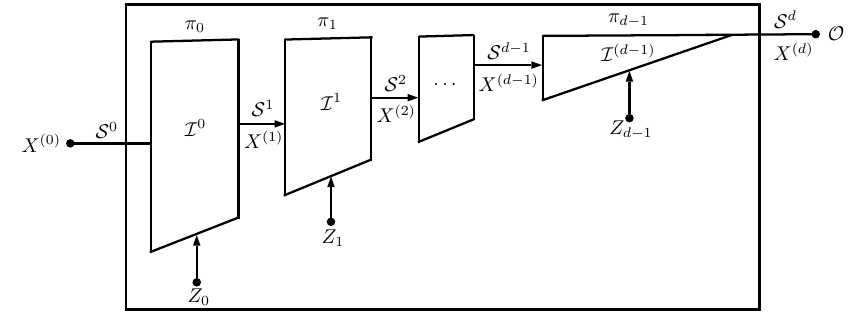
Figure 11: Internal functioning of Gadget AMtoMM ( ·